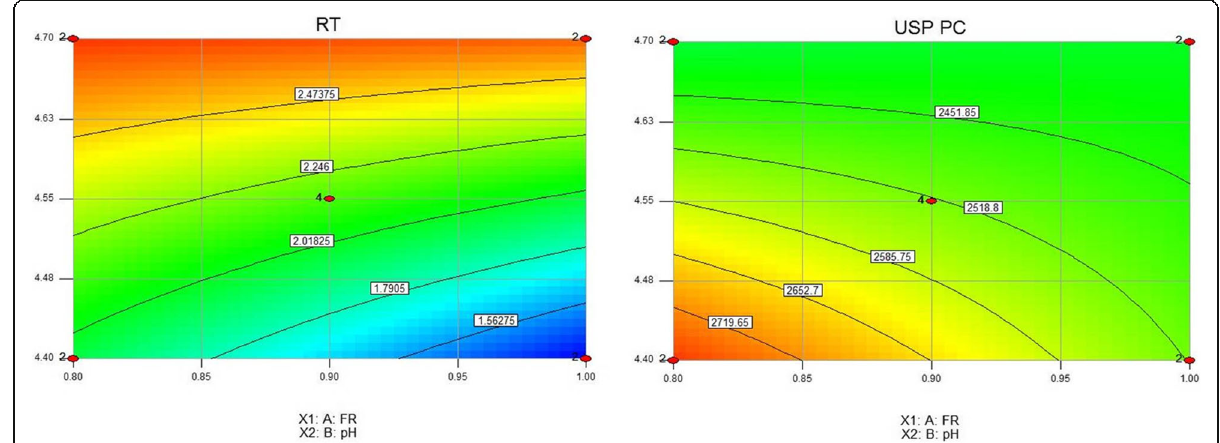
Fig. 2 Contour plot showing the effect of flow rate and pH on retention time and USP plate count